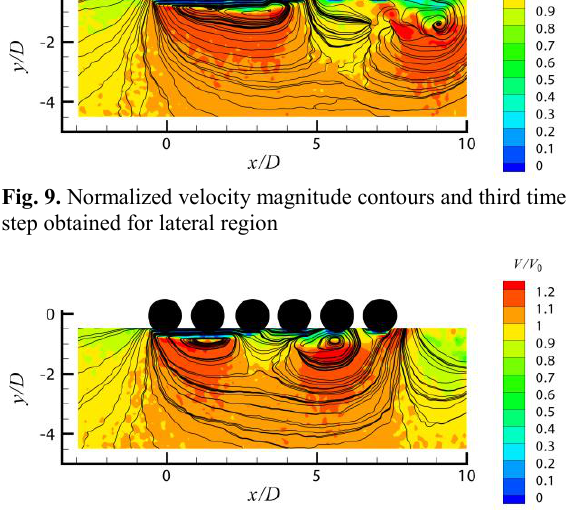
Fig. 10 Normalized velocity magnitude contours and fourth time step obtained for lateral region Mean velocity components and their standard deviations are showed in Fig. 11-14.